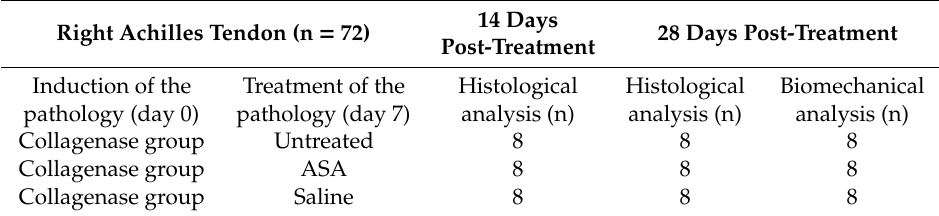
Table 1. Model Overview and Treatment